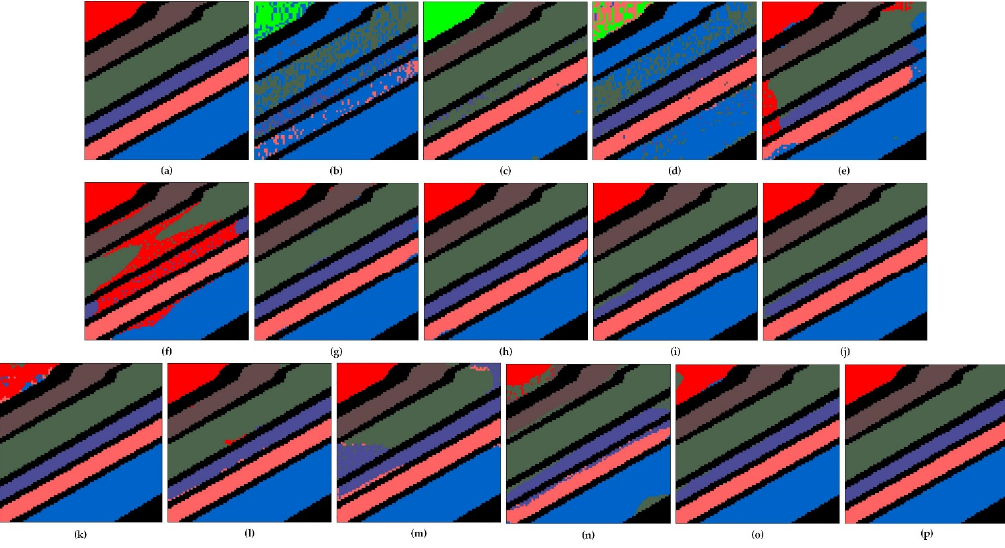
Figure 15. Classification maps on the SAC dataset. ( a ) Ground truth. ( b ) SVM. ( c ) RF. ( d ) MLR. ( e ) 1D_CNN. ( f ) 2D_CNN. ( g ) 3D_CNN. ( h ) 2D_3D_CNN. ( i ) RSANN. ( j ) SSAN. ( k ) MAFN. ( l ) DCRN.